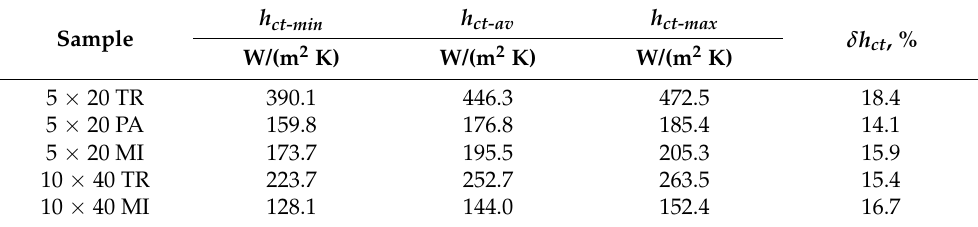
Table 7. The minimum, average and maximum values of h cd obtained for individual samples.